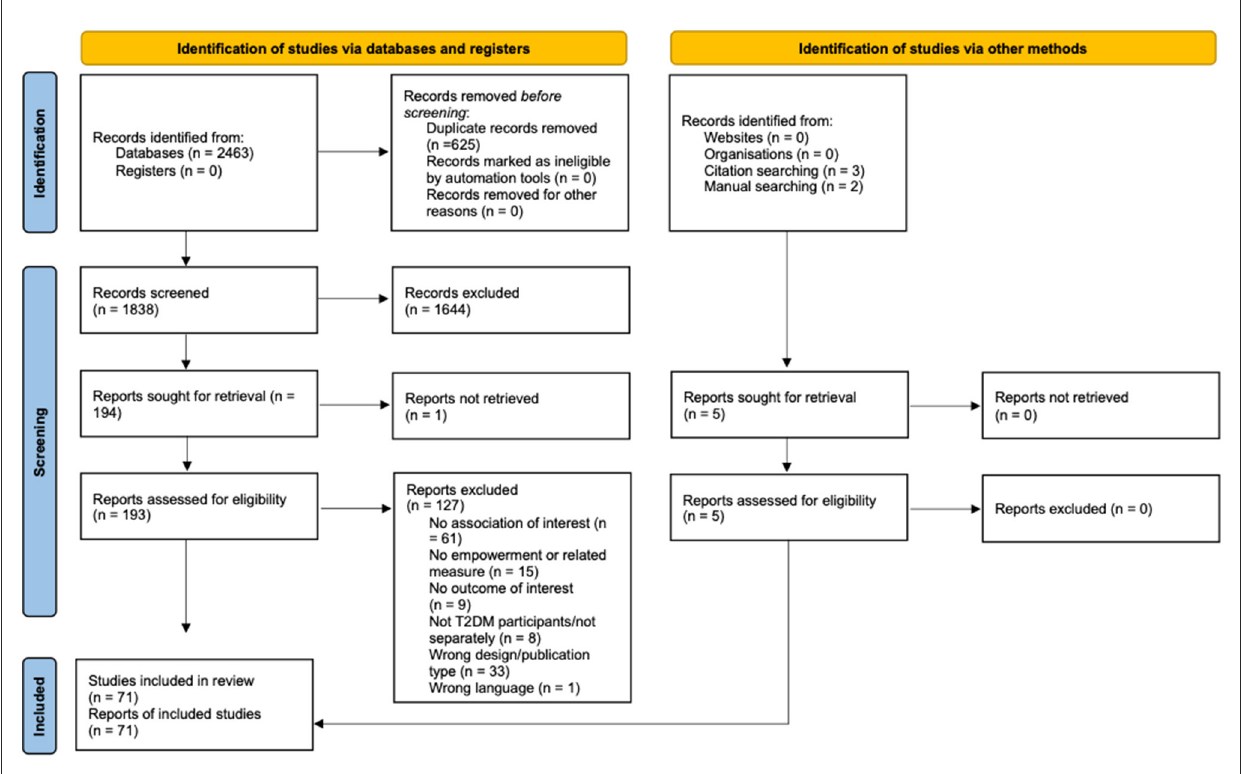
FIGURE2 PRISMA flow-chart of the study selection